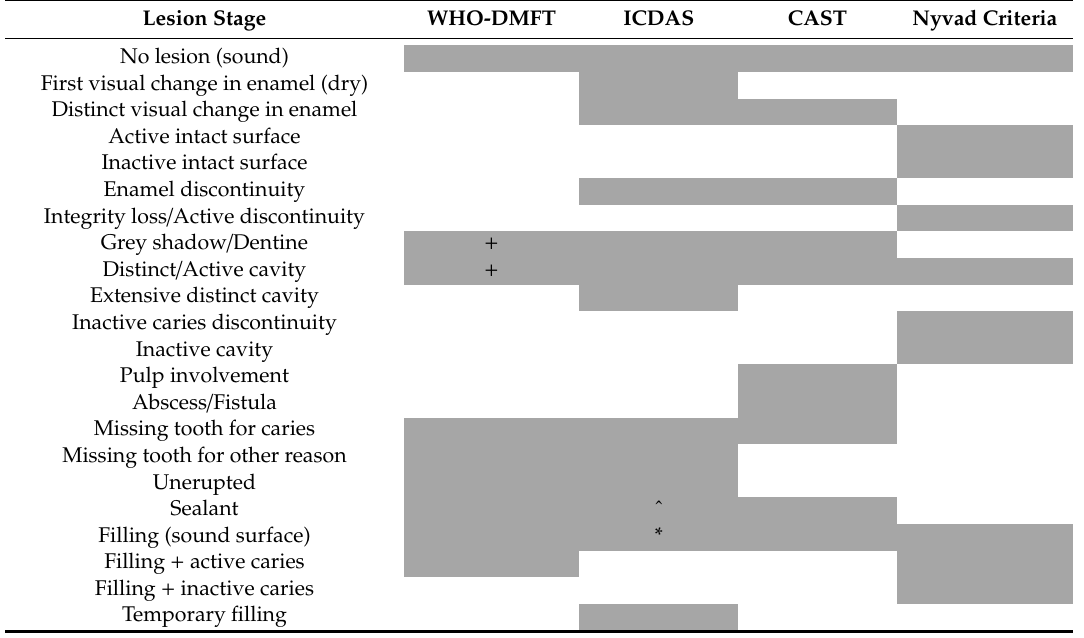
Table 1. Hierarchy Clinical Code scores